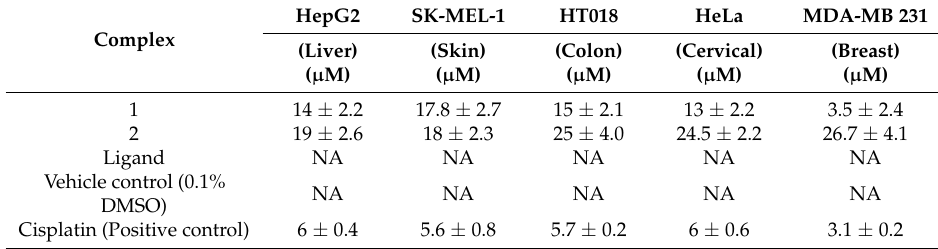
Table 4. IC 50 values of complexes 1 , 2 , the ligand, and cisplatin against five human cancer cell